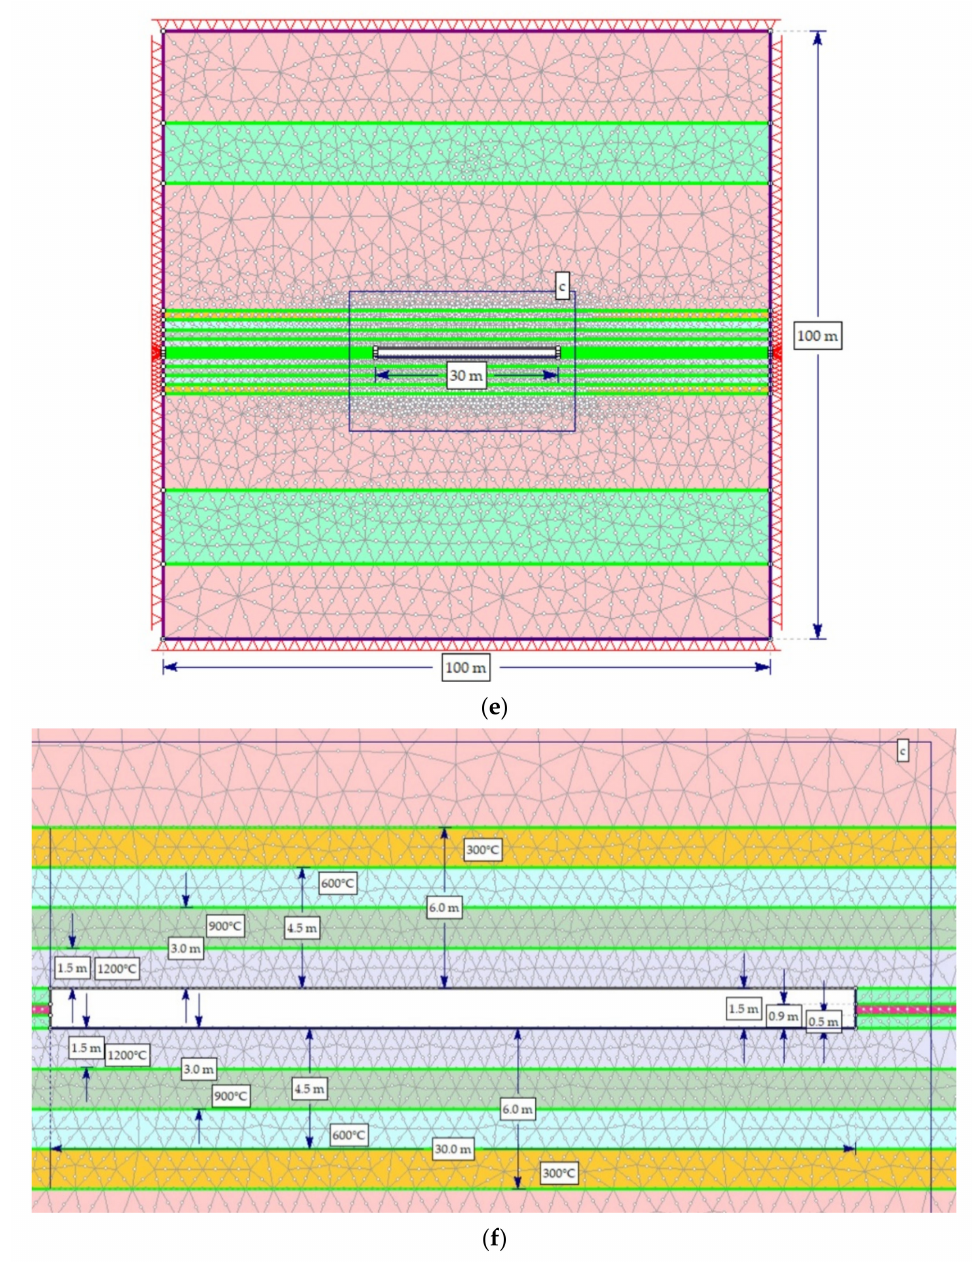
Figure 11. Numerical models: ( a ) channel width 10 m; ( b ) detail “a”; ( c ) channel width 20 m; ( d ); detail “b”; ( e ) channel width 30 m; ( f ) detail